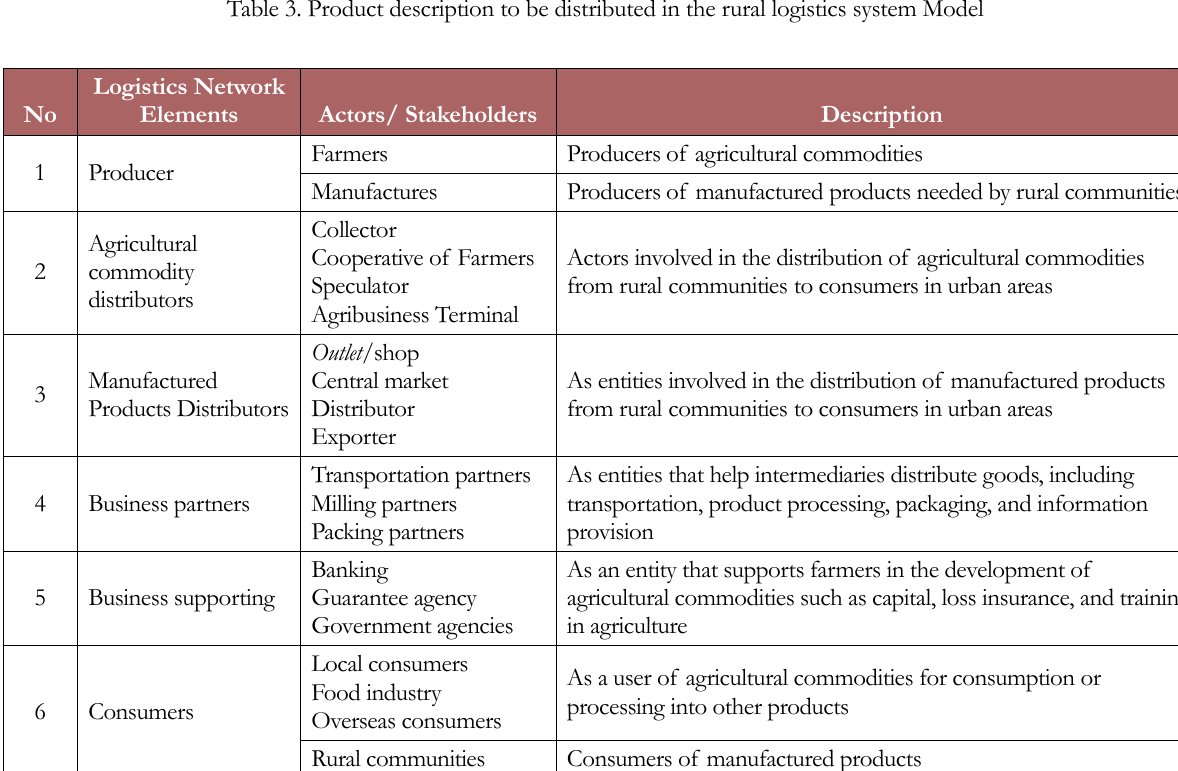
Table 4. The results of the identification of logistics components in rural